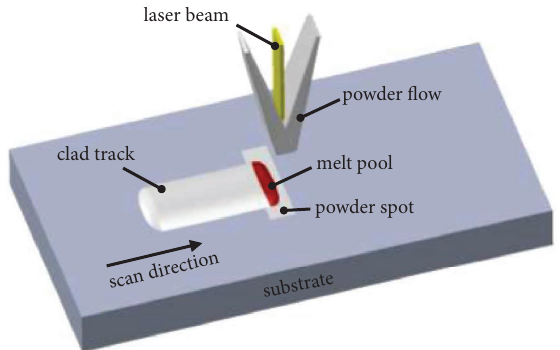
Figure 3: Schematic diagram of single-track